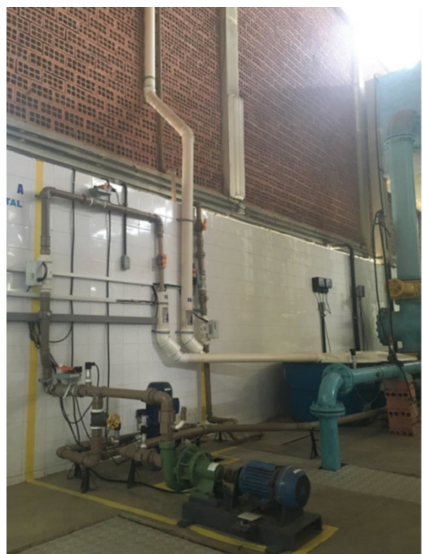
Figure 4. Experimental bench.